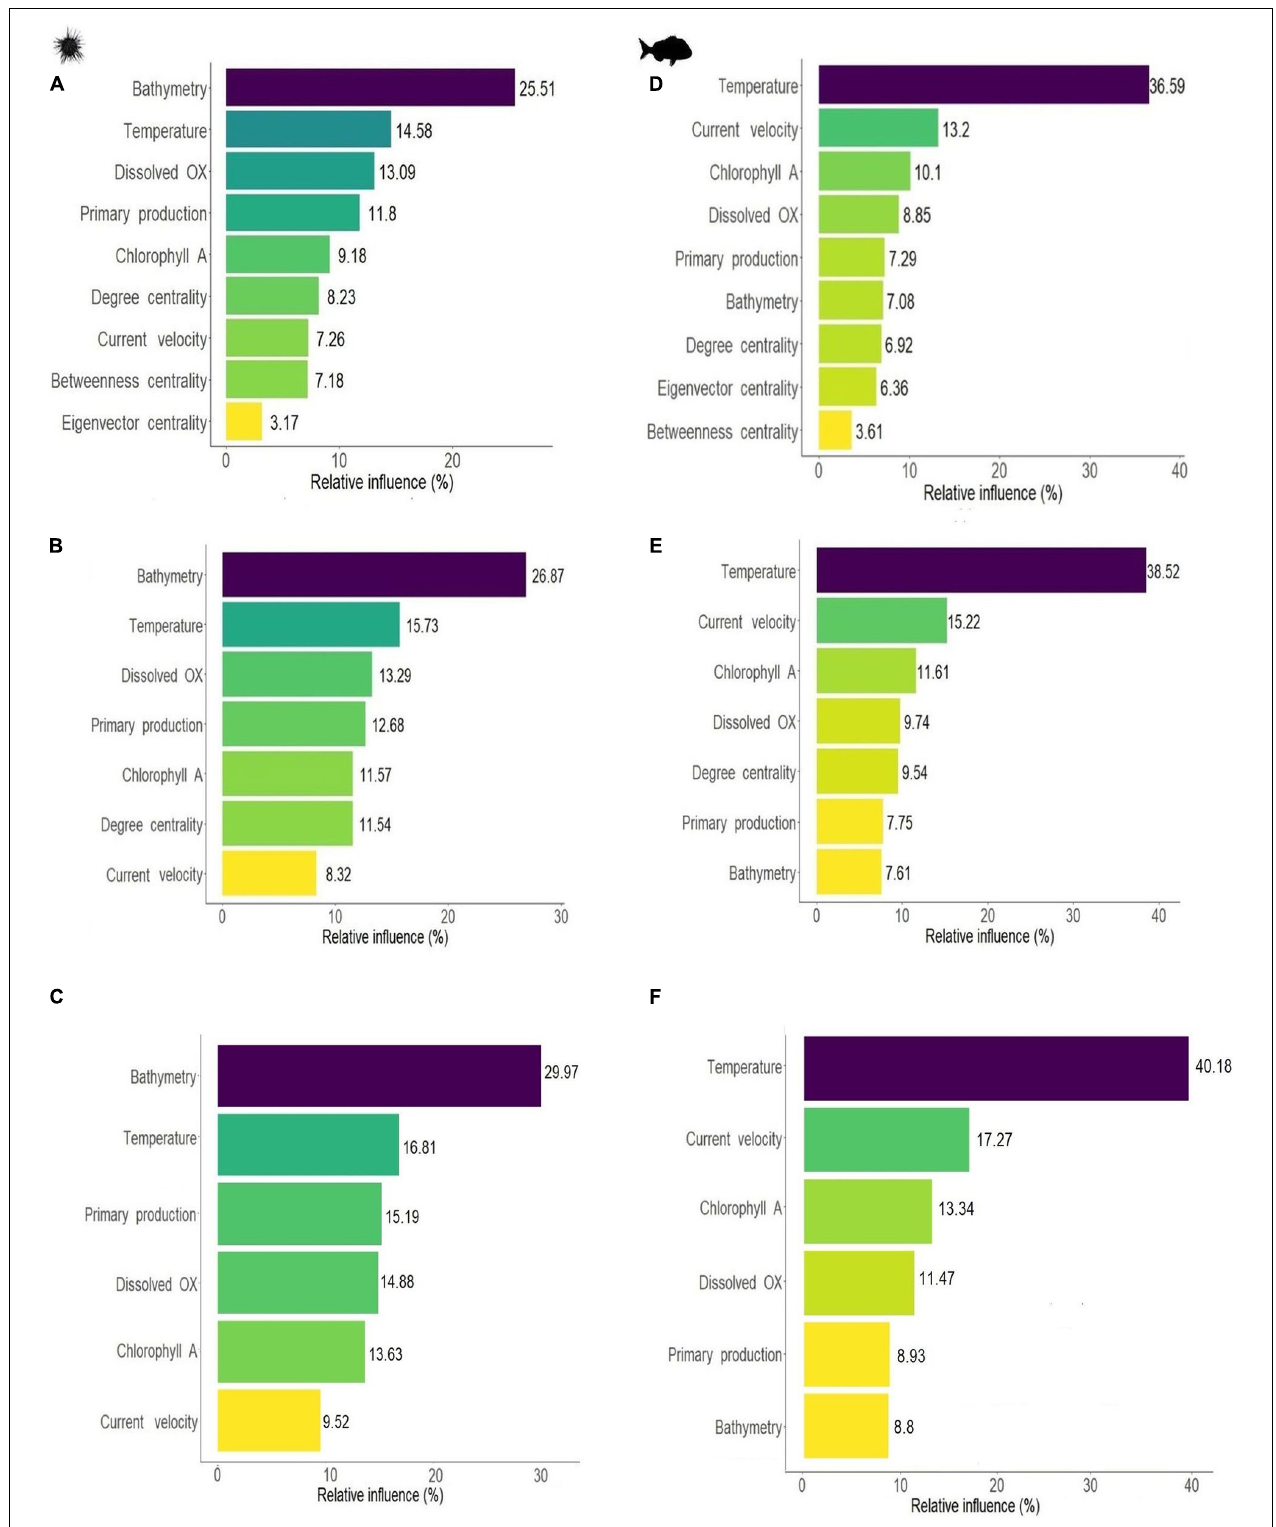
FIGURE 3 | Relative influence of environmental parameters and centrality metrics on SDM results for sea urchin H. erythrogramma (left) and snapper, C. auratus (right). Fitting BRT including all centrality measures (A,D) or selecting only the most influential variable degree centrality (B,E) , or excluding centrality (C,F) . Relative influence expressed in percentage (i.e., total influence sums up to